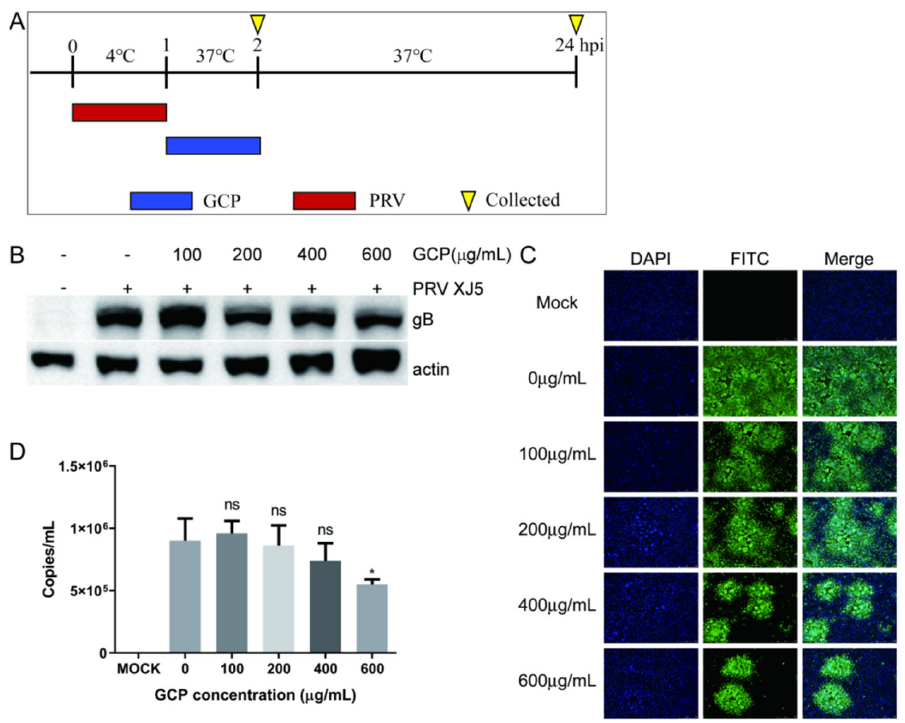
Figure 6. GCP decreased the internalization of PRV. ( A ) PK ‐ 15 cells were first infected with PRV XJ5 (MOI = 0.1) at 4 °C for 1 h, then incubated with GCP for another 1 h at 37 °C. ( B , C ) At 24 hpi, the expression levels of gB protein and actin were analyzed by Western blot and the internalized virus was detected by immunofluorescence assay. ( D ) At 2 hpi, the copy numbers of PRV DNA were quantified by qRT ‐ PCR. All results were obtained from three independent experiments and were presented in means ± SD (ns, not significant; * p 0.05).